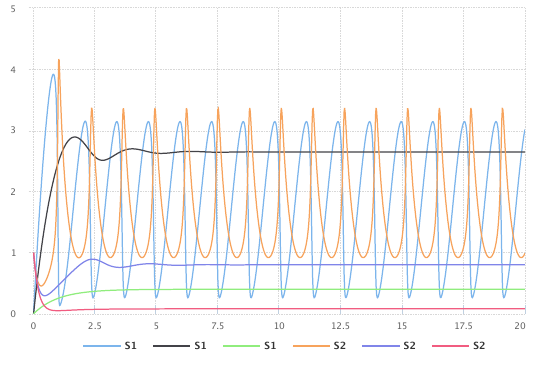
Figure A.4: Simulation with tellurium